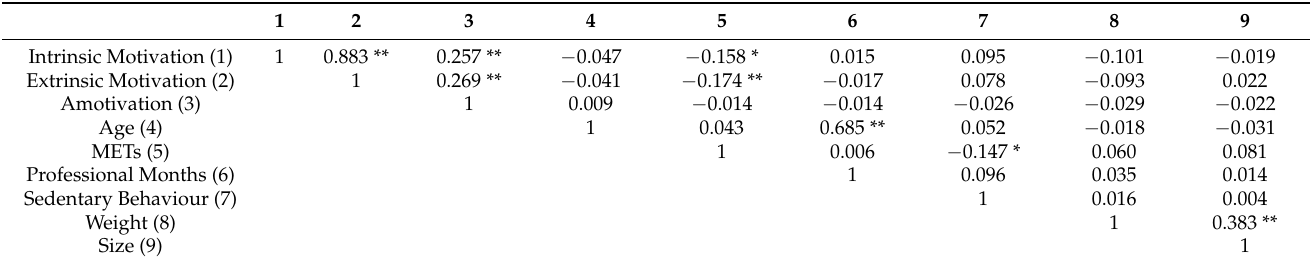
Table 5. Correlation between dimensions of the SMS scale and socio-demographic